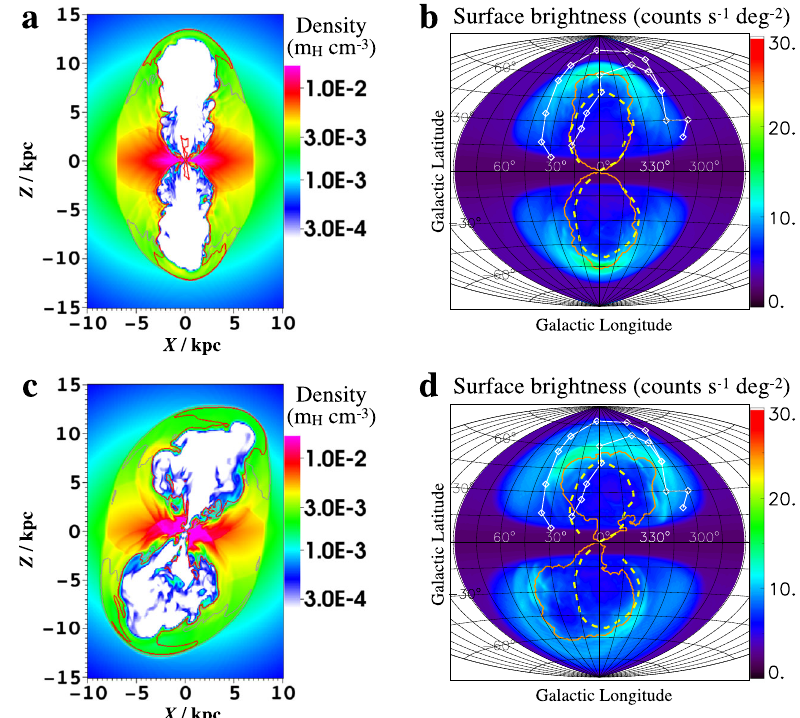
Fig. 6 | Simulations of other scenarios. Density distributions and X-ray maps for the non-axisymmetric halo medium (upper, t =19 Myr) and tilted nuclear out fl ow model (lower, t =18 Myr). The grey and red lines in panels a and c represent iso- thermsof3×10 6 and4×10 6 K,respectively.Theorangelinesinpanels b and d mark the cavities fi lled with the nuclear out fl ow. In both cases, the outlines of the eRBs appear essentially symmetric in the east – west direction. In the titled out fl ow